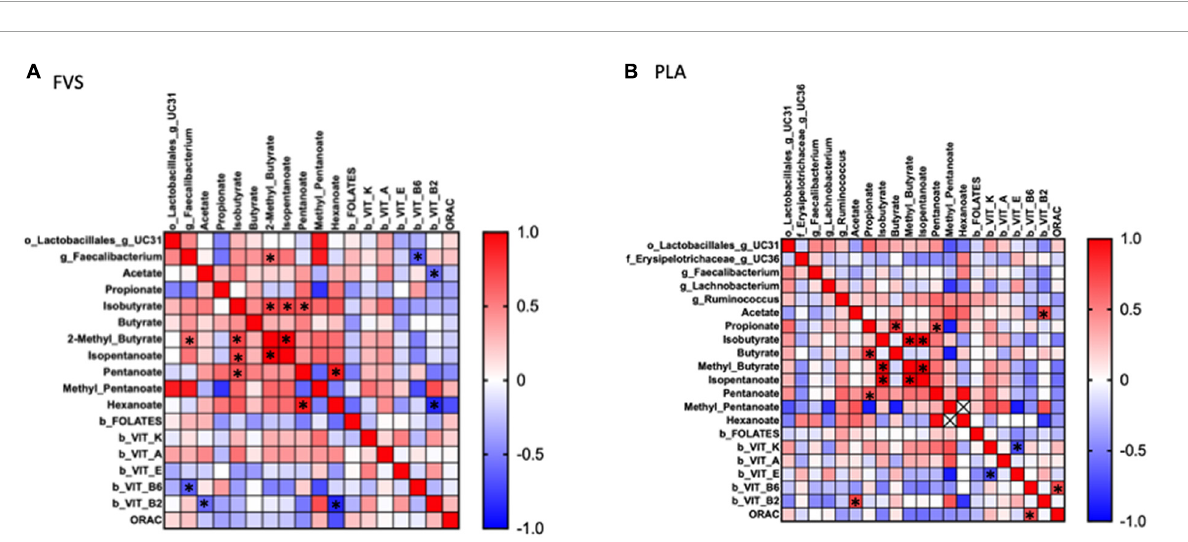
FIGURE7 Correlation analysis between gut microbiome, SCFA, and serum biomarkers in the FVS and PLA groups. Spearman correlation was performed to analyze the interaction between significant microbial genus, SCFA, and serum biomarkers in both the FVS group (A) and PLA group (B) . Red to blue color scale indicates a positive to a negative correlation, respectively. FVS, N = 15, PLA, N = 14. ∗ p < 0.05 when compared with the PLA group.